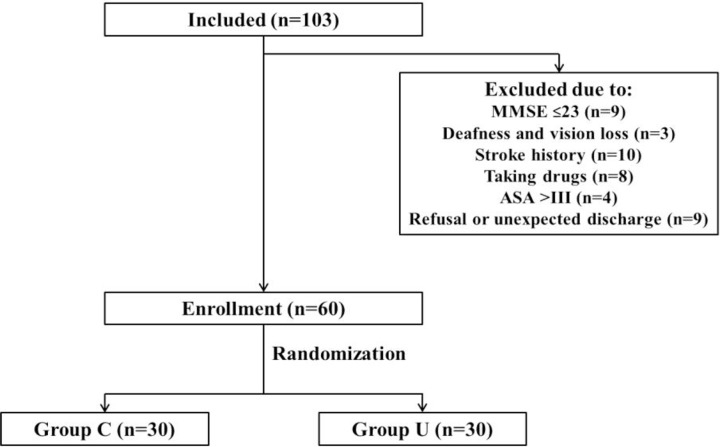
The patient recruitment flow chat.